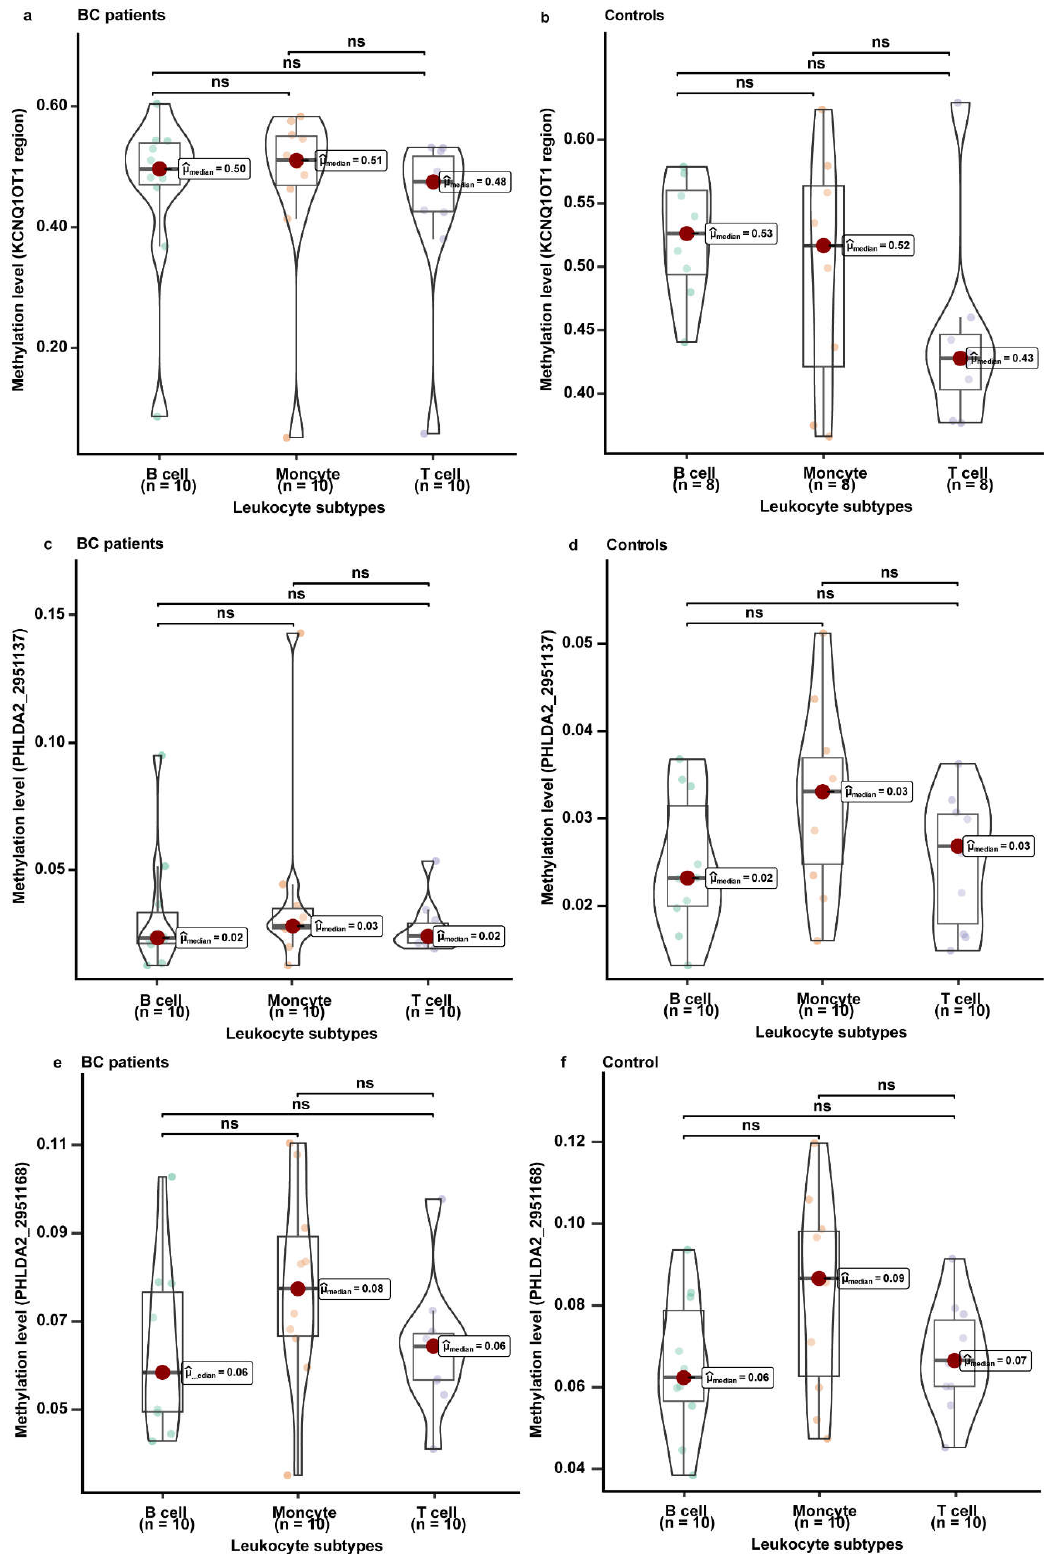
Figure 4. The methylation levels of the KCNQ1OT1 region and PHLDA2 in B cells, monocytes, and T cells. The methylation levels were measured in the samples (bisulfite-converted DNA from B cells, monocytes, and T cells) from 10 breast cancer patients and 10 healthy controls. The methylation levels between different leukocyte subtypes were compared using the Kruskal–Wallis test. ( a ) The